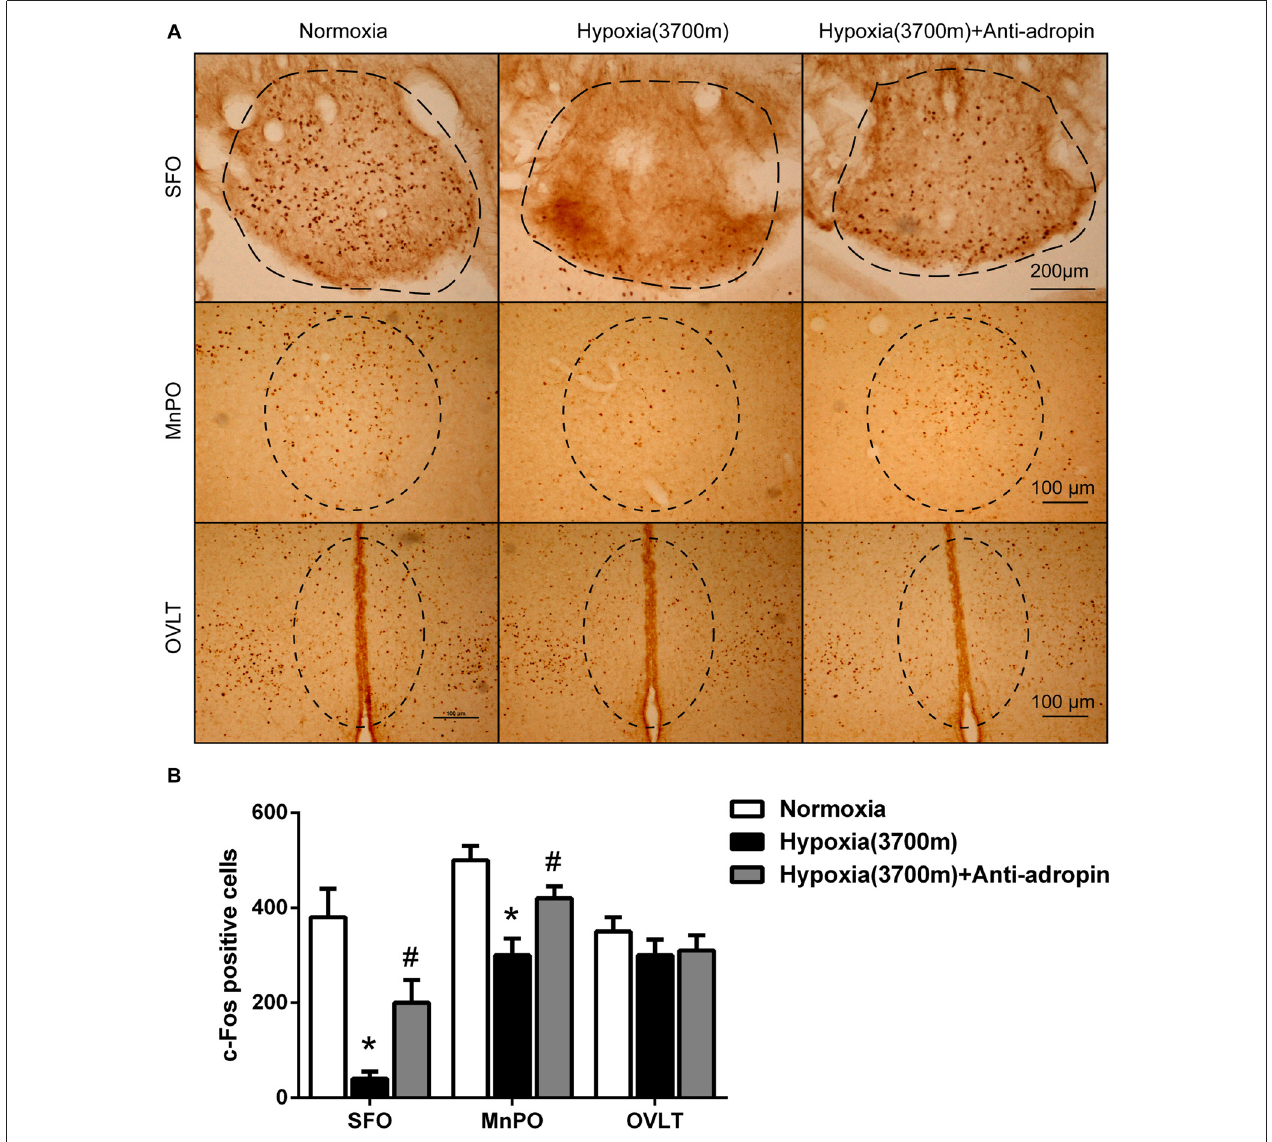
FIGURE 2 | Suppression of c-Fos under hypoxia was relieved when adropin was neutralized in CVO nuclei of rats. (A) The reduction of c-Fos positive cells (visualized as brown staining) in Subfornical organ (SFO) and Median preoptic nucleus (MnPO) regions under hypoxia (3700 m) was recovered 25 h after administration of 10 µ l adropin antibody in the third ventricle after overnight water deprivation-induced drinking in rats, Scale bar, SFO:200 µ m, MnPO, OVLT: 100 µ m. (B) Quantification of c-Fos positive cells (three rats for each group; ∗ P < 0.05 vs. normoxia group, # P < 0.05 vs. 3700 m hypoxia